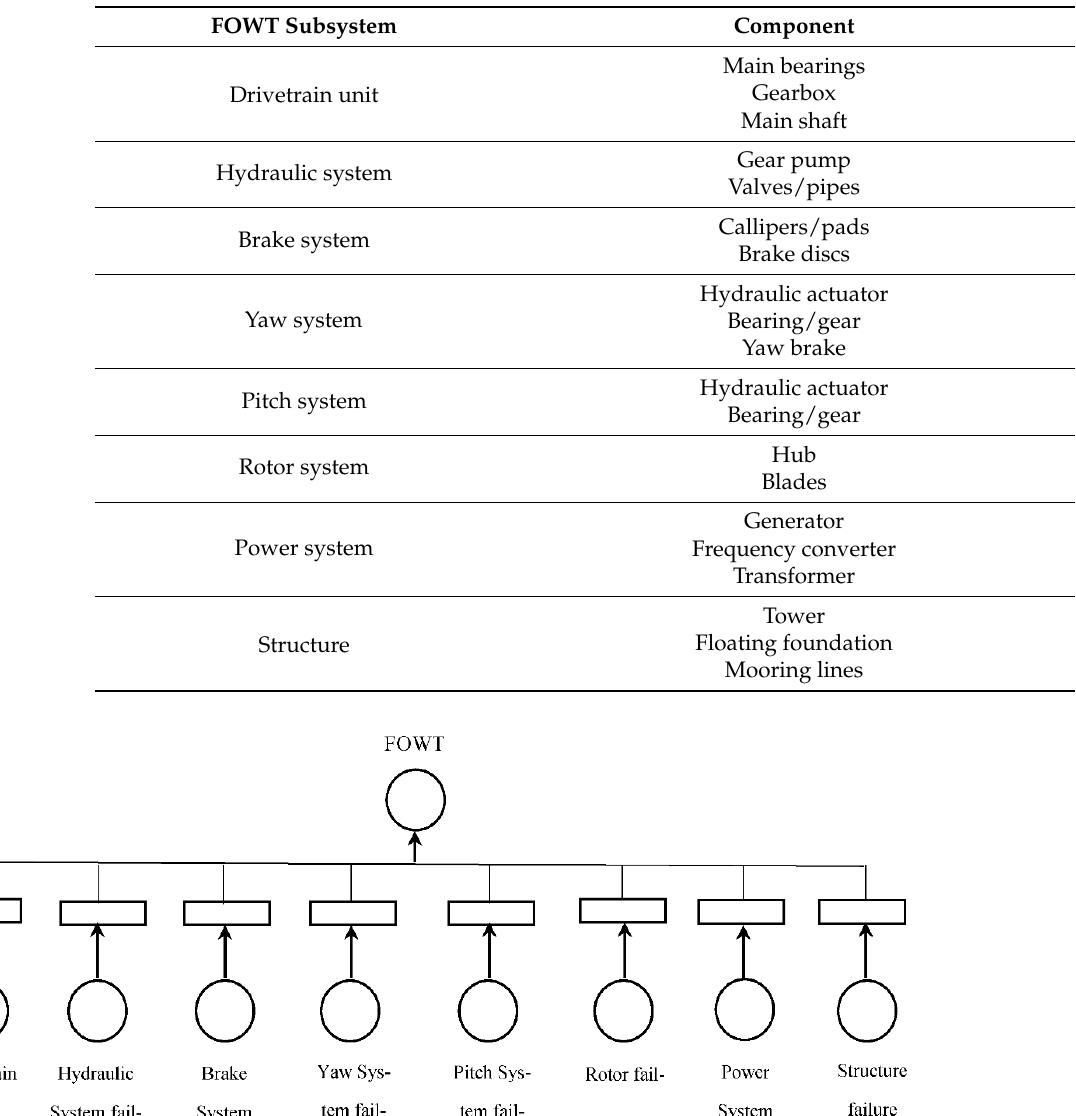
Table 2. Floating offshore wind turbine (FOWT) subsystems and components.